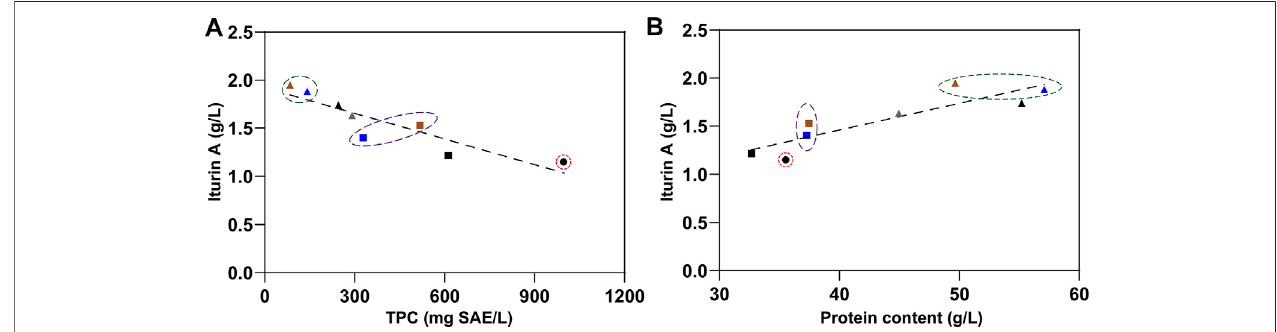
FIGURE6| TherelationshipbetweenTPCanditurinAproduction (A) orbetweenproteincontentanditurinAproduction (B) .BlackcirclerepresentedRSM.Black, blue and brown square represent RSMeR, 92011eR and 48424eR, respectively. Gray, black, blue and brown triangle represent RSM-P, RSMeR-P, 92011eR-P and 48424eR-P,